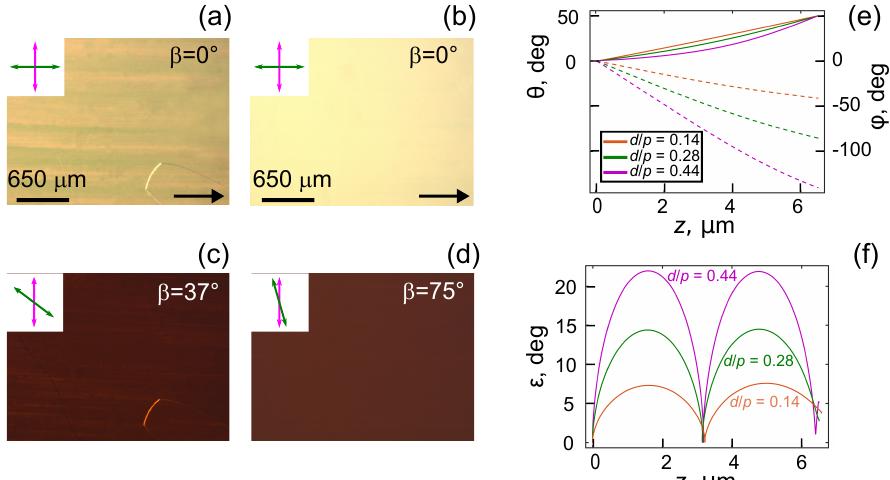
Figure 5. POM photos of cholesteric layers with confinement ratio d / p = 0.14 ( a , c ) and d / p = 0.28 ( b , d ). Calculated dependences of tilt angle θ ( z ) (solid lines), azimuthal angle ϕ ( z ) (dashed lines) ( e ) and corresponding dependences of ellipticity angle ε ( z ) ( f ) for the samples with d / p = 0.14 (orange line), d / p = 0.28 (green line) and d / p = 0.44 (magenta line). POM photos are taken using white light when β angle between analyzer and rubbing direction of PVA film is 0 ◦ ( a , b ). POM photos are taken using the interference filter ( λ = 602nm) when β angle is 37 ◦ ( c ) and 75 ◦ ( d ). Polarizer is perpendicular to the rubbing direction. LC layer thicknesses are 6.5 µ